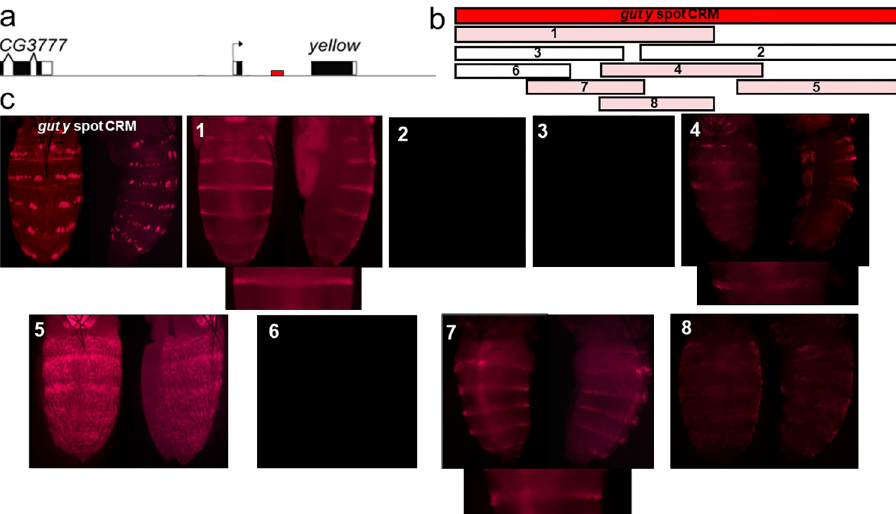
Fig 7. The gut y spot CRM is harbored within the y intron. a, The y gene locus. The red bar indicates the relative position of the gut y spot CRM. b, Subdividing the gut y spot CRM revealed horizontal stripes on each abdominal segment. The rectangular bars (1–8) represent sub-fragments of the gut y spot CRM and the corresponding pupal DsRed expression patterns in transgenic D . guttifera during stage P10 are shown in c. The sub-fragments that drove reporter expression are highlighted in pink (#1, #4, #5, #7, and #8), whereas the constructs that did not show any pattern are shown as rectangular white bars (#2, #3, and #7). For sub-fragments #1, #4 and #7, an additional image focusing on a single stripe is shown below the abdominal images that show horizontal stripes on the abdomen. Sub- fragment #7 shows the minimal y stripe core CRM with reporter expression along the dorsal